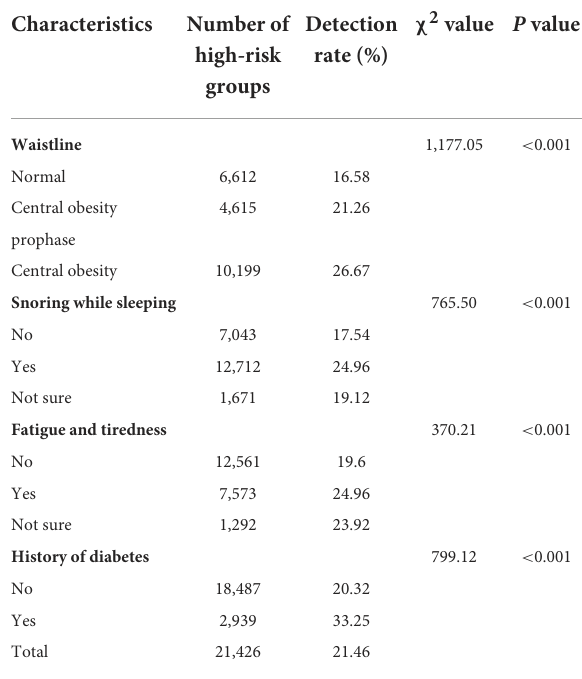
TABLE 3 Comparison of the detection of high-risk groups of CVD among residents with different